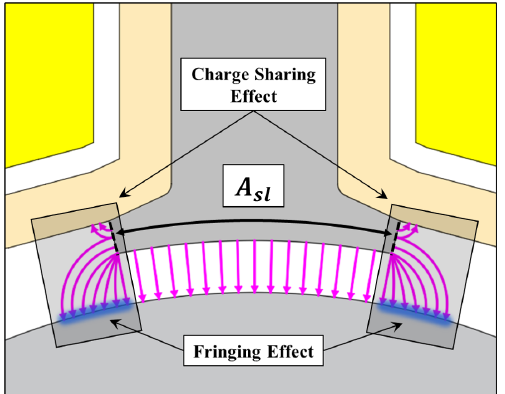
Figure 8. Electric field distribution between the stator and rotor for parasitic capacitance calculation.